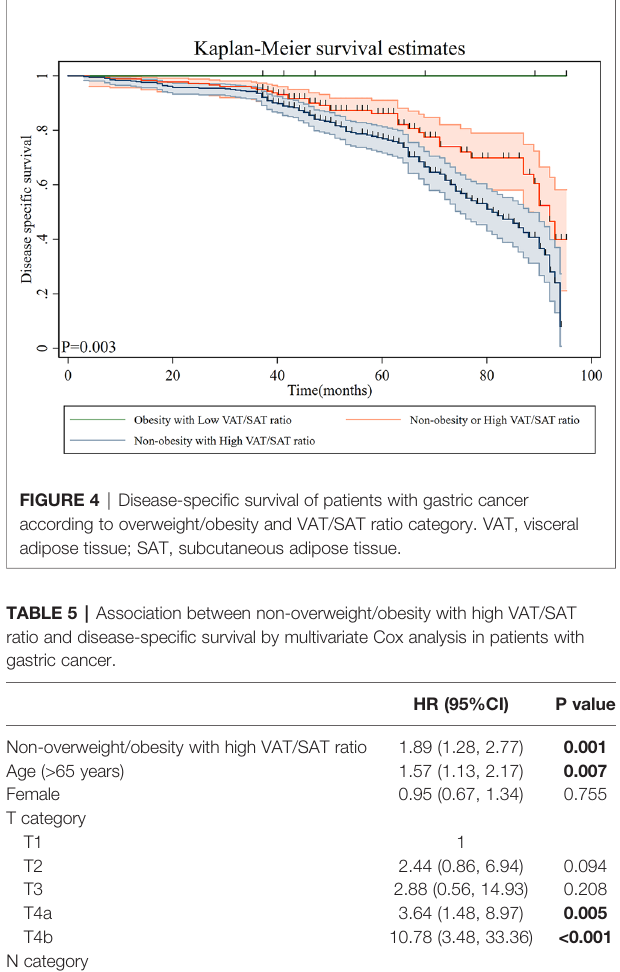
SAT, subcutaneous adipose tissue; VAT, visceral adipose tissue; HR, hazard ratios; CI, con fi dence interval. Bold values represent statistically signi fi cant differences (P <